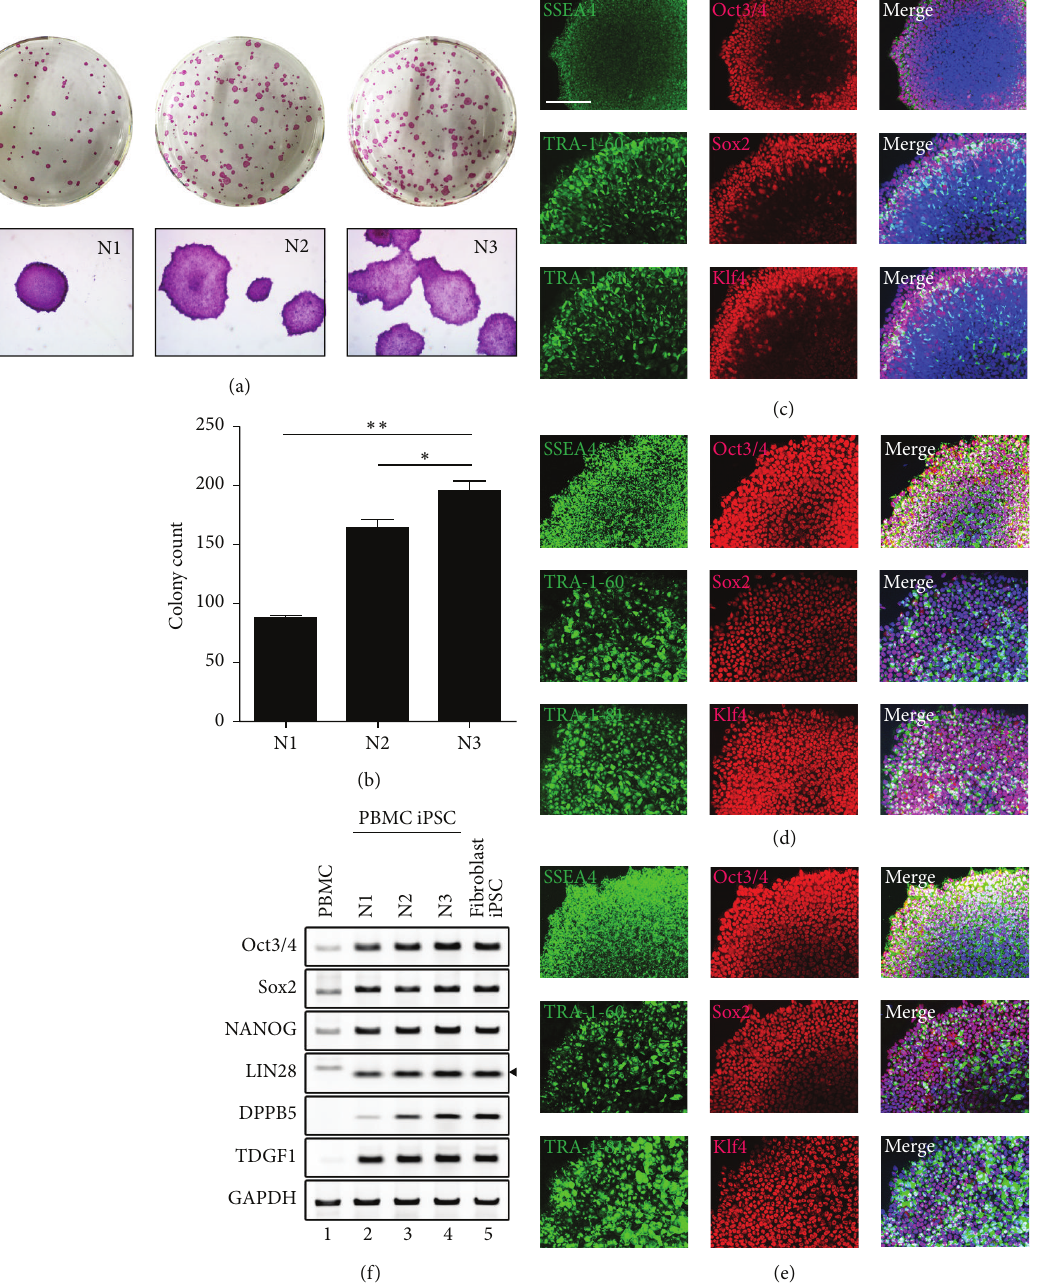
Figure 2: Stemness characterization of iPSCs generated by the established protocol. (a) Brightfield image of AP-stained clones. The N3 clone showed the highest number of colonies after 7 days. (b) Colony count of the AP-stained cells in Figure 2(a). Immunocytochemical staining of N1 (c), N2 (d), and N3 (e). N3 showed a slightly higher expression of pluripotency markers than N1 and N2. ( ∗ 𝑃 < 0.05 ; ∗∗ 𝑃 < 0.01 ). (f) Gene expression of pluripotency markers in each clone was confirmed by RT-PCR. Cells were compared to raw PBMCs and fibroblast-derived iPSCs. Scale bars: 200 𝜇